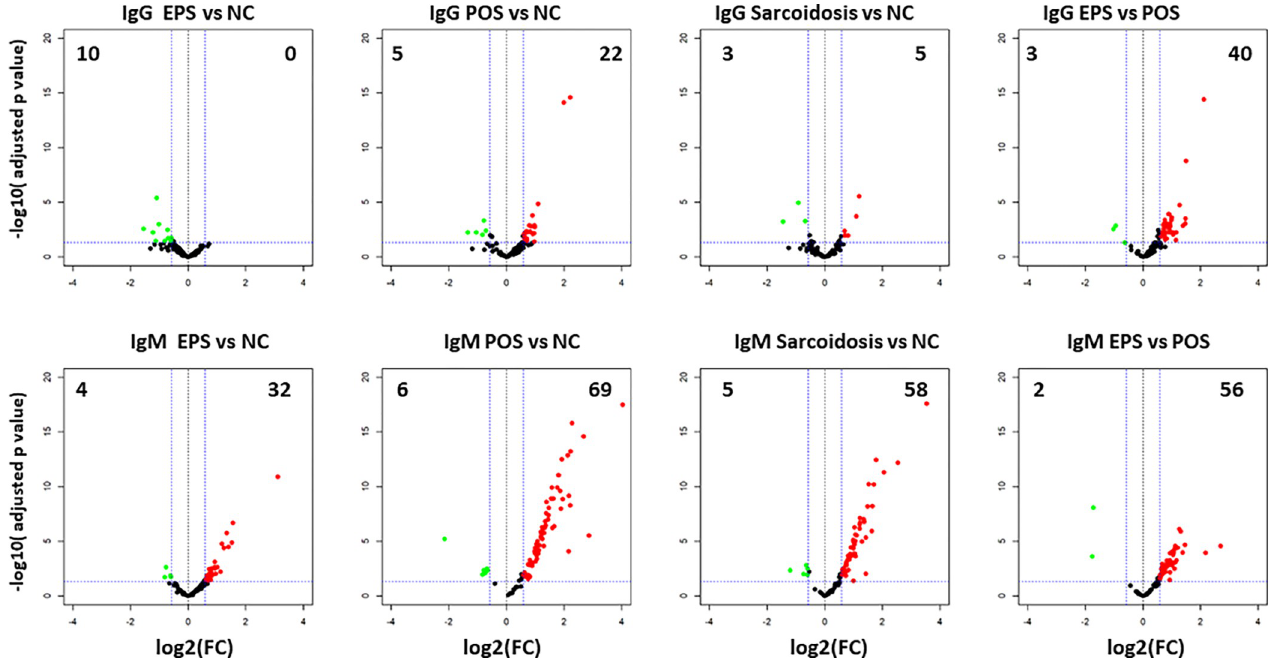
Fig 1. Autoantigen microarray analysis identified differential IgG and IgM autoantibody profiles in three groups (EPS: extra-pulmonary sarcoidosis; POS: pulmonary only sarcoidosis; NC: normal control; sarcoidosis is combination of EPS and POS). Sera from 120 EPS, 106 POS and 101 NC were assayed for autoantibodies using a high-throughput 120 autoantibody microarray platform. Volcano plots of IgG autoantibodies (top row) and IgM (bottom row) displaying each autoantibody as a single point with—log10(p value) on the y axis versus log2(FC) on the x axis. Red points indicate a statistically significant increase in mean autoantibody levels for each group comparison, green points indicate a statistically significant decrease for each group comparison. Fold changes are shortened as FC.